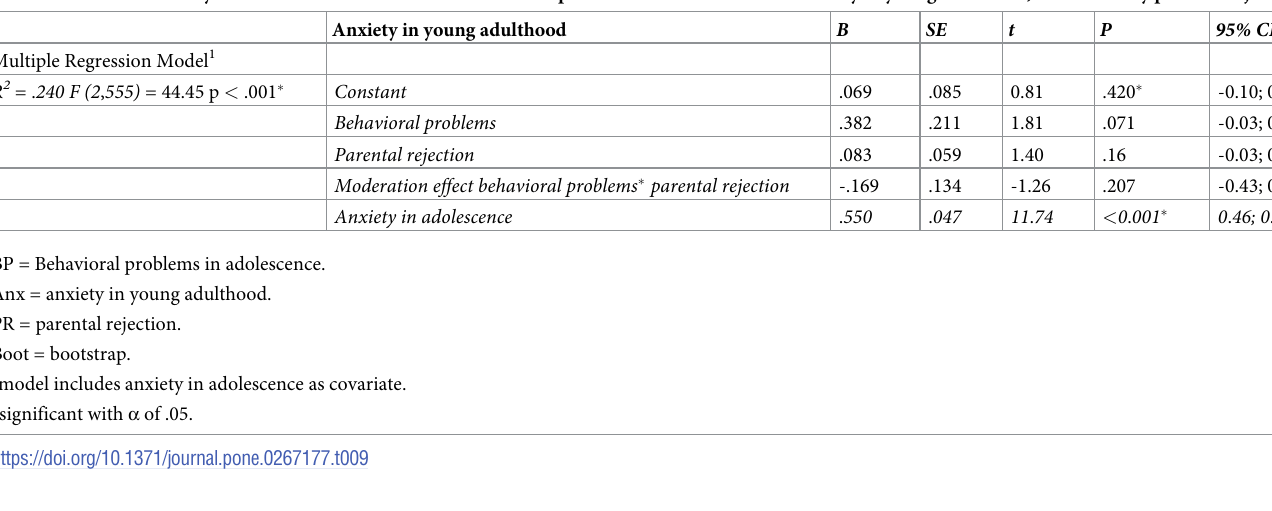
Table 9. Moderation analysis for the association between behavioral problems in adolescence and anxiety in young adulthood, moderated by parental